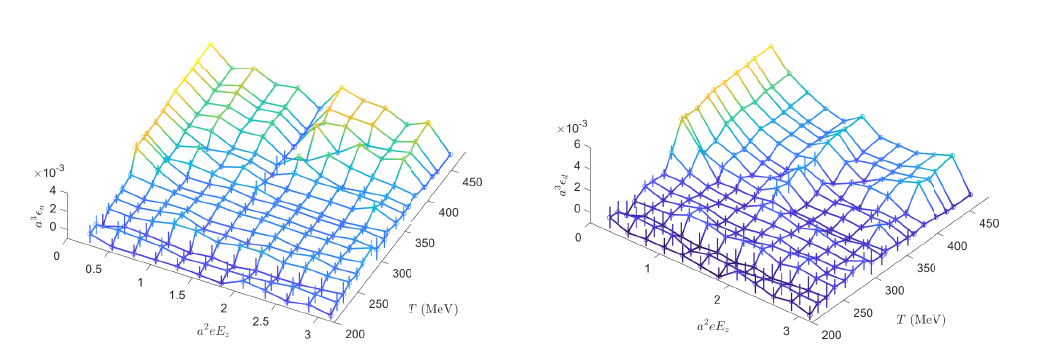
Figure 5 . (cid:15) u (the left panel) and (cid:15) d (the left panel) as functions of temperature T and E z